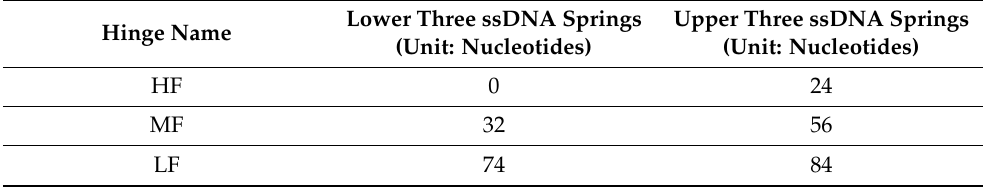
Table 1. Contour length of ssDNA in the base unit of the